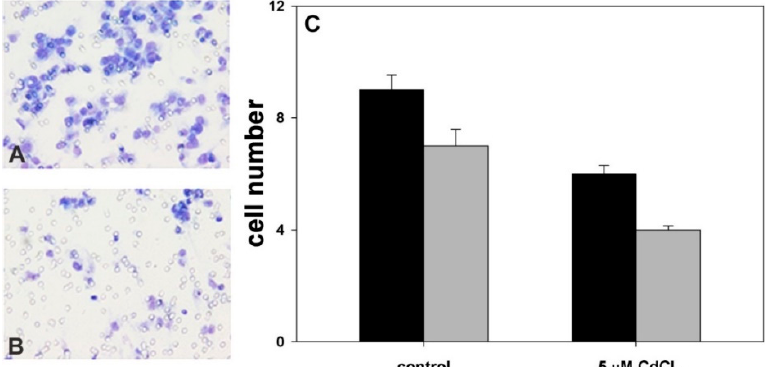
Figure 4. Representative low-magnification images captured at 6 h showing control ( A ) and 5 µM CdCl 2 -treated MDA-MB231 cells ( B ) migrated through the filter pores in chemotaxis assays. Microscopic magnification = 40 × . ( C ) Histogram showing the number of migrated cells in chemotaxis (black bars) and chemoinvasion assays (gray bars) in the two experimental conditions. The results are expressed as the mean ± standard error of the mean (SEM) of six different experiments.